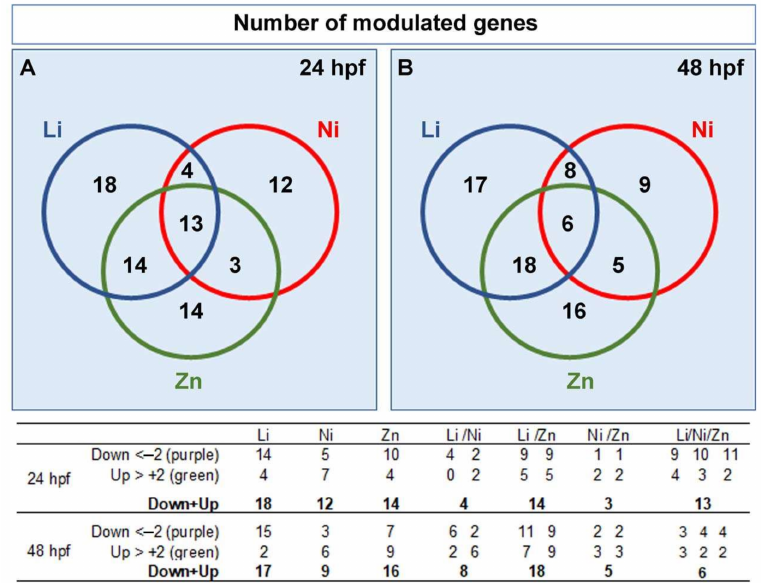
Figure 8. Venn diagrams reporting the numbers of modulated genes in different subgroups, i.e., in Li, Ni, Zn, Li/Ni, Li/Zn, Ni/Zn, and Li/Ni/Zn. Modulated genes at 24 ( A ) and 48 ( B ) hours post-fertilization (hpf). The table below reports the numbers of down- and up-regulated genes in each